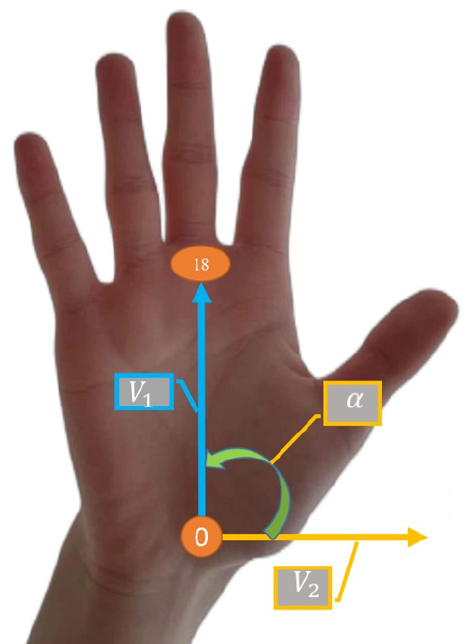
Figure 1. Vectors and angles on the palm. The orientation of the palm is determined based on two vectors and the rotation angle. V 1 represents the direction vector of the palm, and V 2 represents the horizontal vector of the palm. α is the rotation angle of the